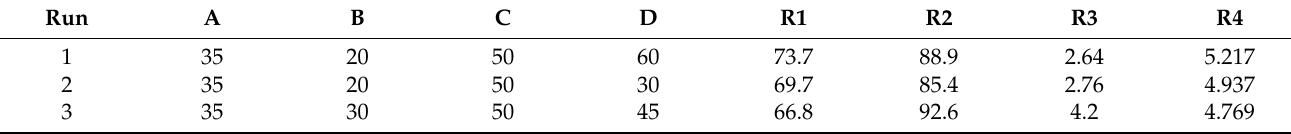
Table 2. Box–Behnken design (B-BD) matrix and experimental responses. Factors A, B, C, and D in the table represent ultrasound pretreatment time (min), ultrasound pretreatment temperature ( ◦ C), ripening treatment temperature ( ◦ C), and ripening treatment RH (%), respectively, and the responses R1, R2, R3, and R4 represents the required time for fruit ripening, percentage of ripened fruit, percentage of damaged fruit, and electrical energy consumption,